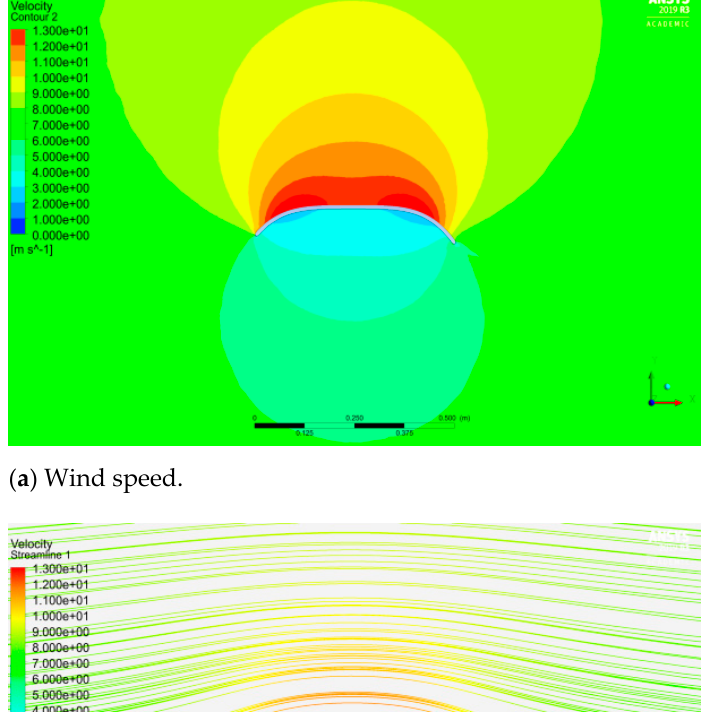
Figure 6. CFD results of the max. speedup ratio case (A) (7 m/s wind from left, top to inside the diffuser) .